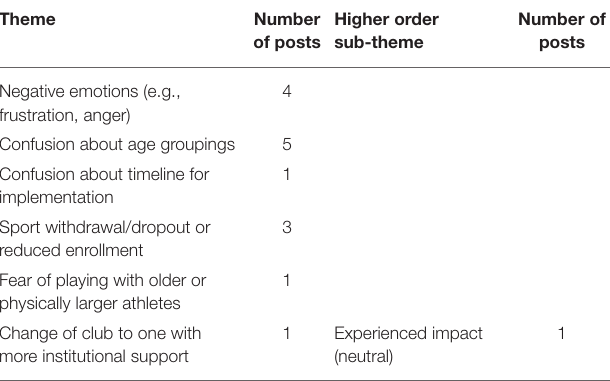
TABLE 4 | Category: recommended courses of